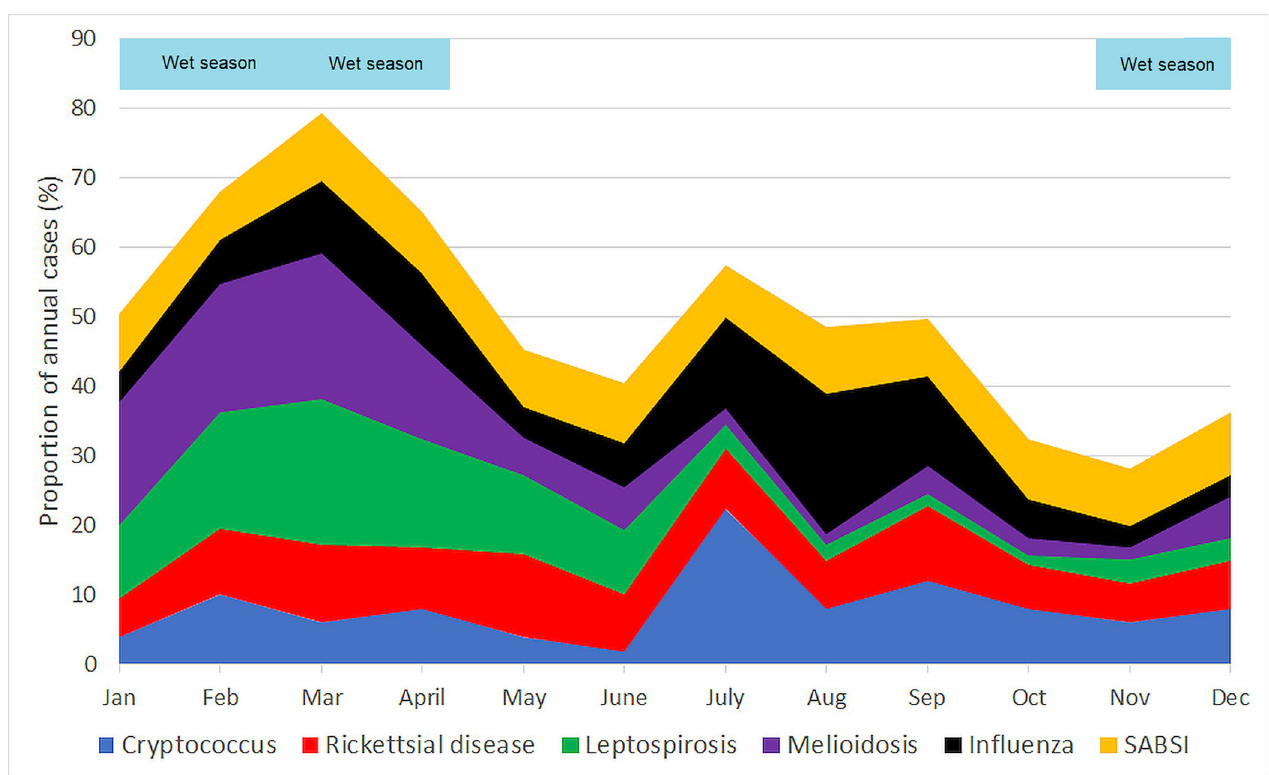
Fig 3. Proportion of the annual number of cases seen in each month in Cairns, Far North Queensland, 1998–2019. The November-April (inclusive) wet season is highlighted in pale blue at the top of the figure.